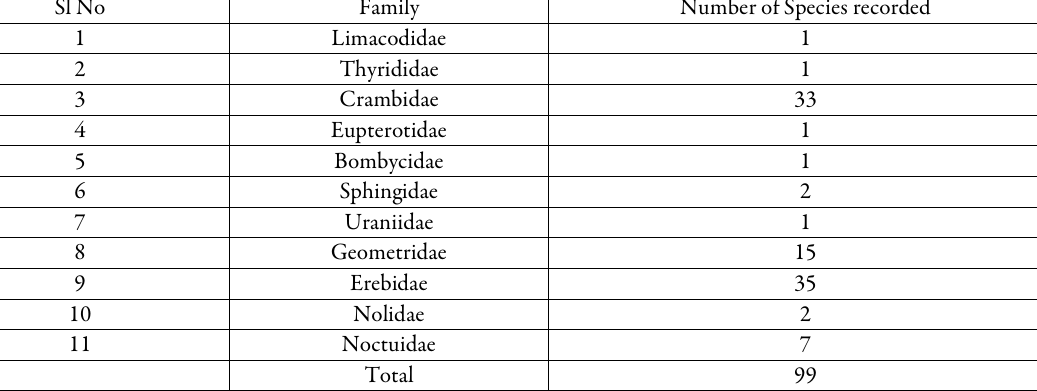
Table 2. Family wise number of species recorded during the survey Sl